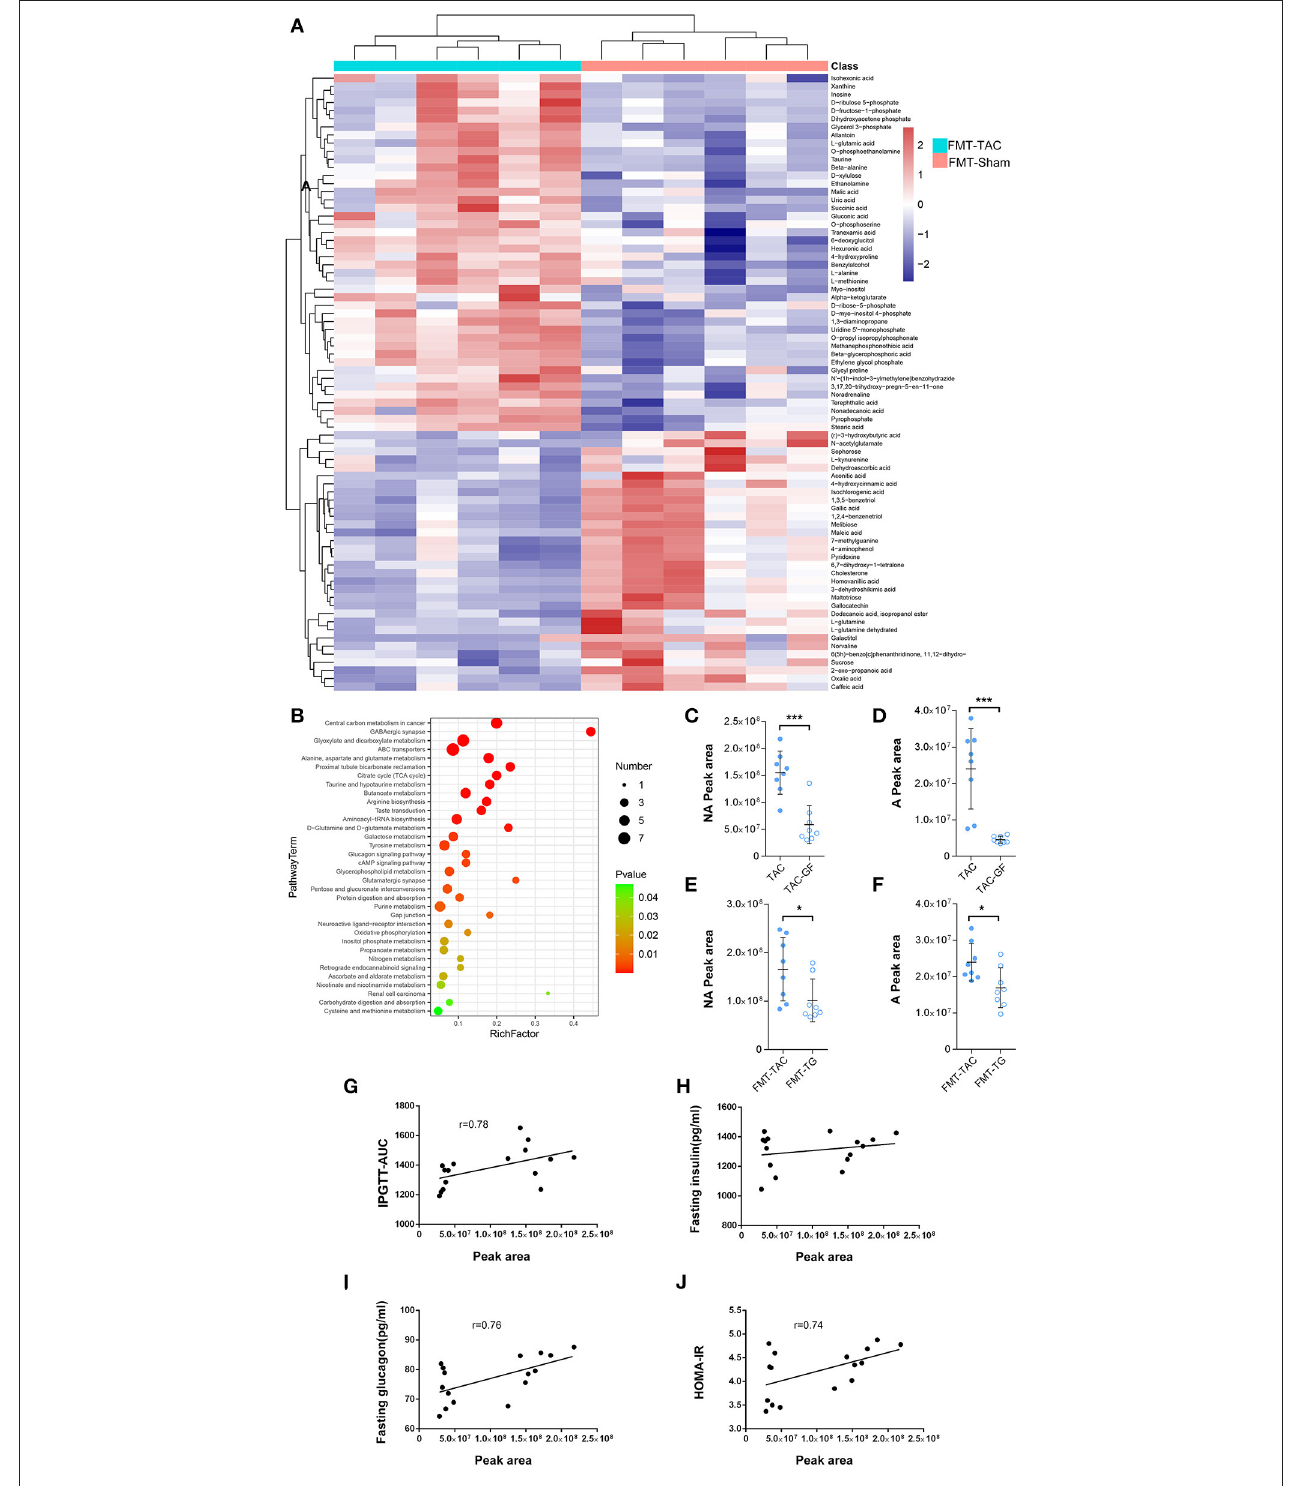
FIGURE 8 | Serum metabolism was altered by fecal microbiota transplantation (FMT). (A) Heatmap of serum metabolism. Red indicates upregulation, and blue indicates downregulation. (B) The Kyoto Encyclopedia of Genes and Genomes (KEGG) pathway enrichment analysis. The color from green to red indicates a sequential decrease in the p value; the larger the dot is, the greater the number of metabolites enriched in that pathway. (C,D) Noradrenaline (NA) and adrenaline (A) levels in the fecal samples of thoracic aortic constriction (TAC) mice with or without antibiotic cocktail treatment. (E,F) NA and A levels in the fecal samples of FMT mice transplanted with TAC or TAC germ-free (TAC-GF) mouse samples. (G–J) Correlation analysis between fecal noradrenaline levels and the intraperitoneal glucose tolerance test-area under the curve (IPGTT-AUC), fasting insulin levels, fasting glucagon levels, and homeostasis model assessment for insulin resistance (HOMA-IR). * P < 0.05, *** P <